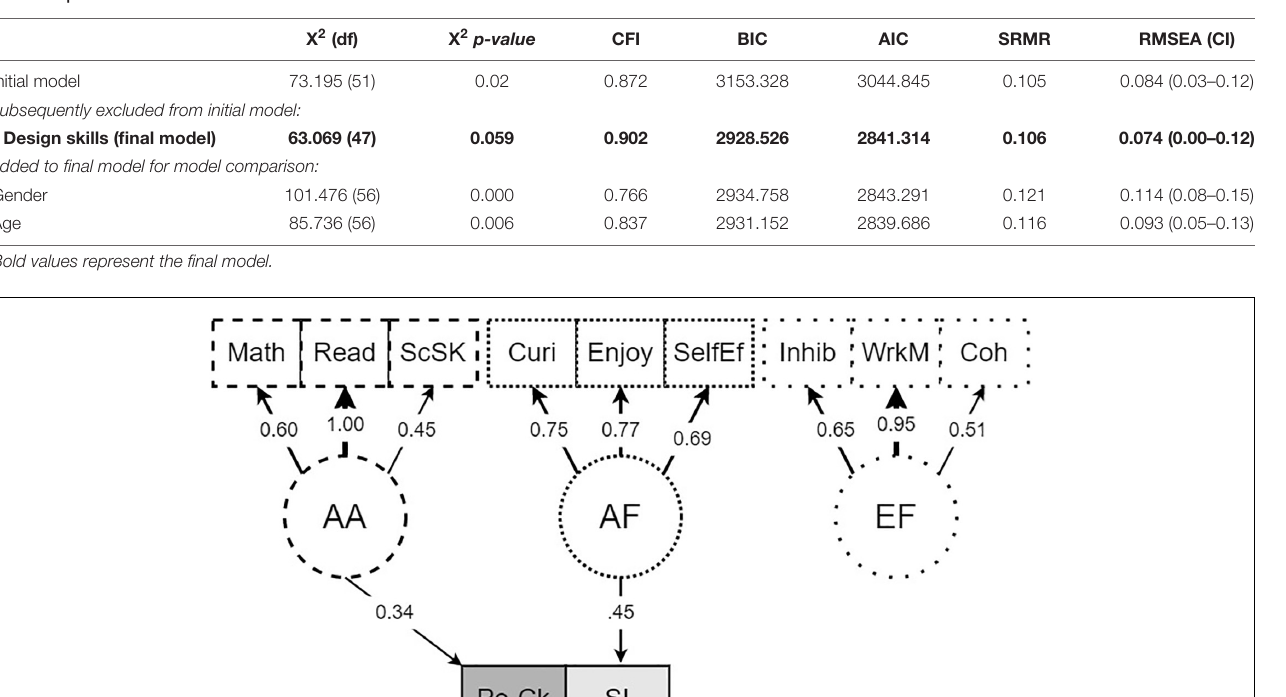
TABLE 5 | Global fit indices for FSR models.